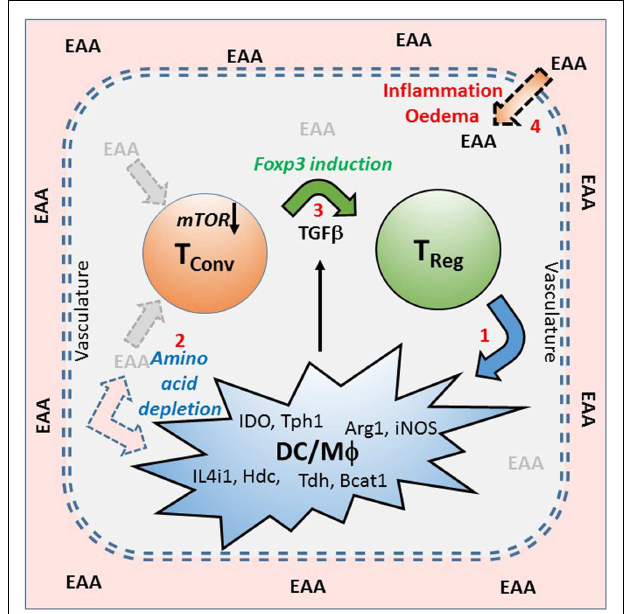
FIGURE 1 |A model of infectious tolerance that depends on a nutrient depleted microenvironment maintained byTreg cells within tissues . This model proposes that immunological tolerance is maintained within tissues by the localized depletion of nutrients, particularly the essential amino acids (EAA), which are required for the proliferation and effector function of conventionalT cells (Tconv). Amino acid depletion is primarily as a result of regulatoryT cells (Treg) inducing (1), in dendritic cells (DC) and macrophages (M φ ), a range of enzymes that catabolize (2) or utilize EAA (examples are shown).This lack of EAA is sensed via the mTOR pathway which, in the presence ofTGF β , encourages the expression of FOXP3, and the induction of furtherTreg (3). Under conditions of tolerance the intact vasculature maintains a barrier between the blood and the tissues, but if there is inflammation or damage to the vasculature, causing edema, then EAA can leak into the tissues (4) and contribute to a breaking of the tolerant